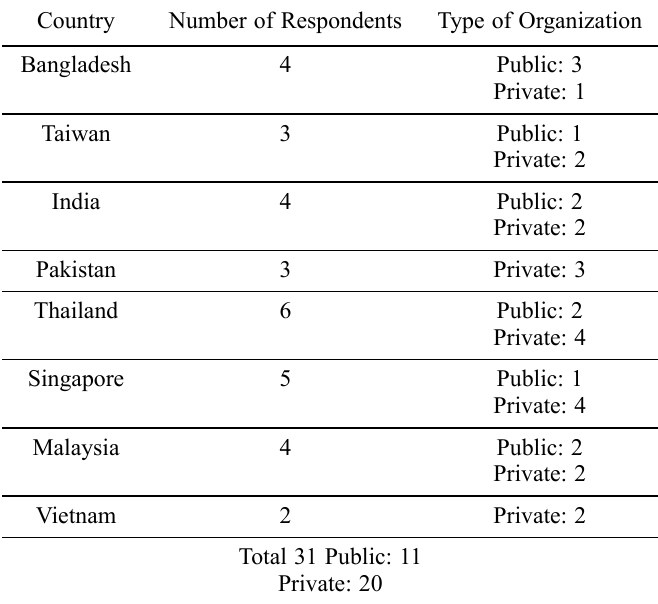
Table 2. Countrywide respondents’